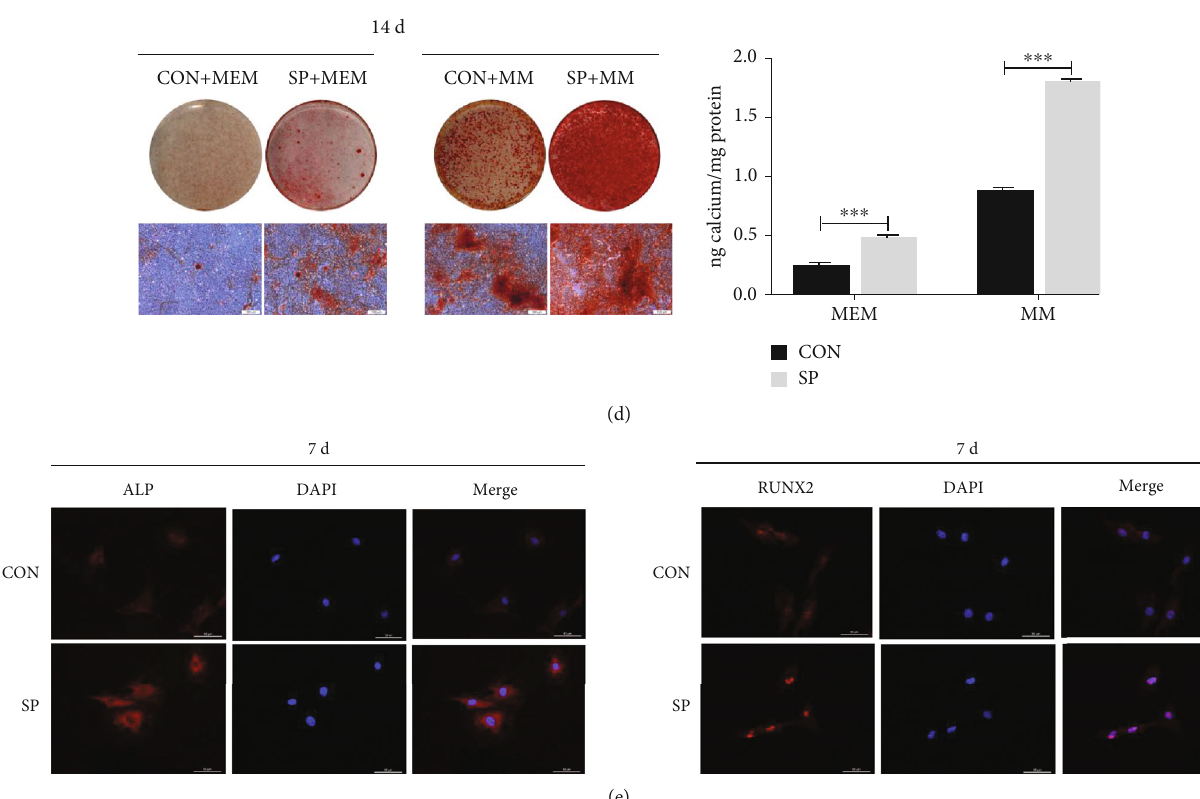
Figure 2: Impact of SP on osteo/odontogenic di ff erentiation of BMSCs. (a) Western blot was used to investigate DSPP, OPN, RUNX2, and OSX protein expression at days 0, 3, and 7. Gray scale inspection of protein bands by ImageJ. ∗∗ p < : 01 , and ∗∗∗ p < : 001 . (b) RT-PCR demonstrated the relative gene expression in the control group, as well as the SP group, at days 0, 3, and 7. ∗∗ p < : 01 , and ∗∗∗ p < : 001 . (c) ALP staining and ALP activity for the control group, SP group, MM group, and MM + 0 : 2mg/ml SP group at day 7. Scale bar = 100 μ m . ∗∗∗ p < : 001 . (d) Figures of Alizarin Red staining and CPC assay in di ff erent groups. Scale bar = 100 μ m . ∗∗∗ p < : 001 . (e) Immuno fl uorescence staining of ALP and RUNX2 in SP-treated